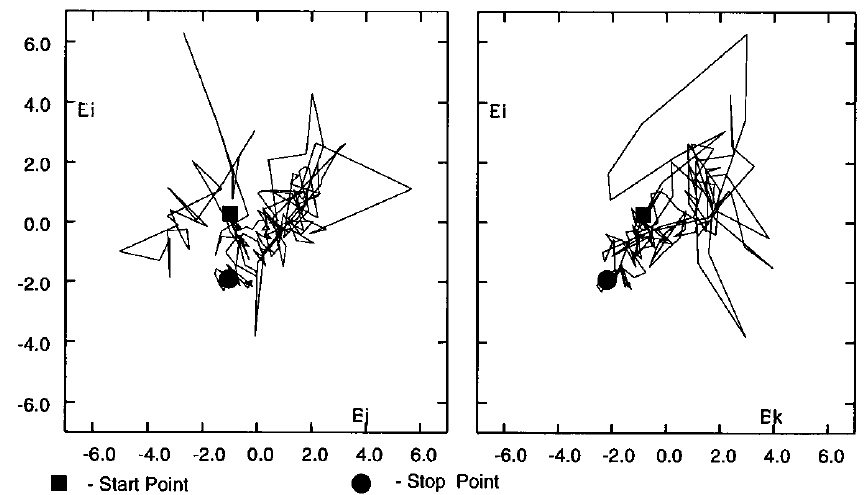
Fig. 4c. Electric field hodogram of the Polar vortex-like structure on 29 May 1996 (see Fig. 4b) in the same coordinate system as in Fig.